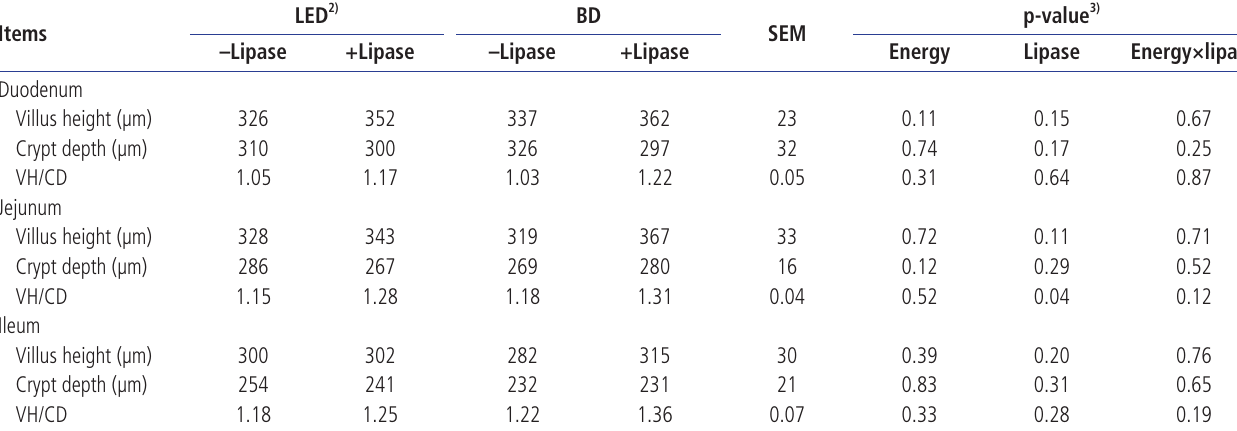
Table 6. Effects of dietary energy and lipase levels on intestinal morphology in weaning pigs 1)